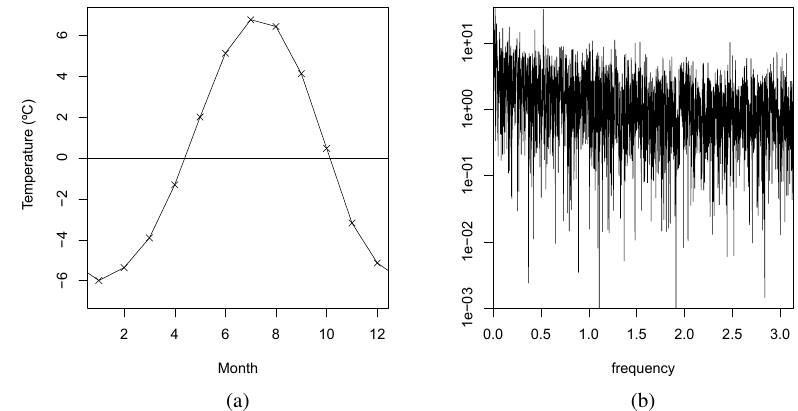
Figure 14. CET time series; (a) assumed deterministic seasonal component S(t) , (b) spectrum of deseasonalized index.